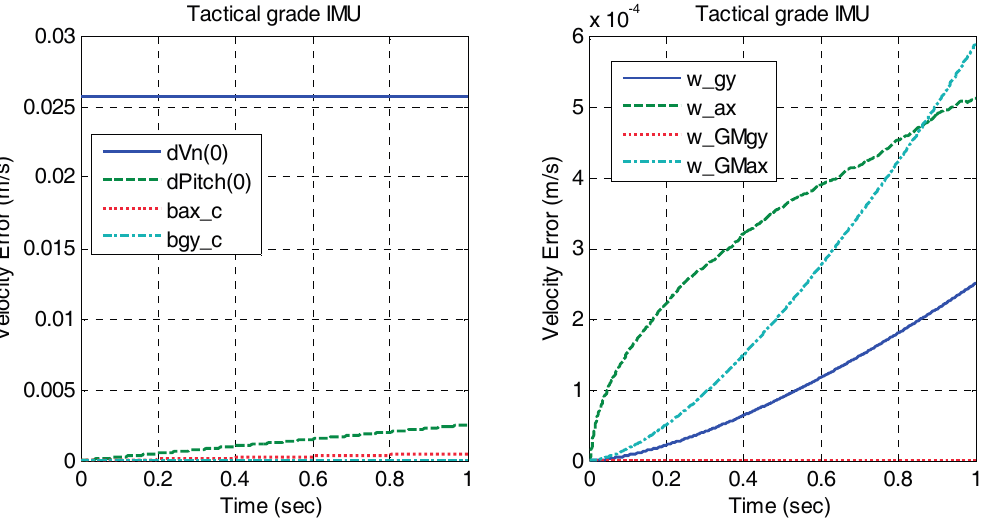
Figure 4. The quantitative velocity errors caused by tactical grade INS error